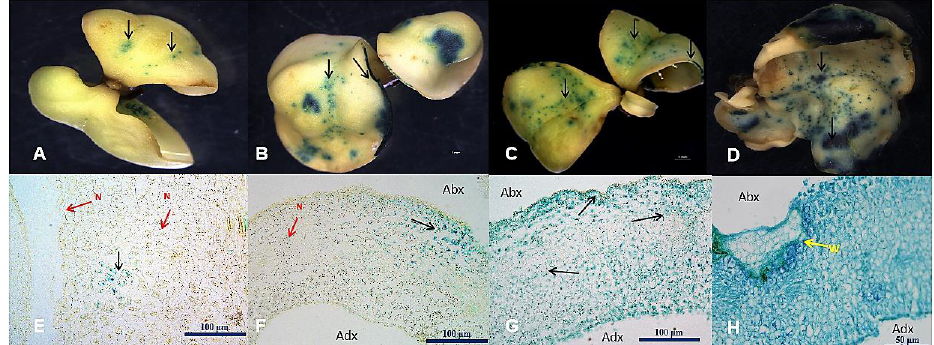
Figure 3. Various levels of GUS expression in Hevea brasiliensis after sonication frequency analysis. ( A , E ) 8 min of agrobacterial inoculation with 10 s sonication, black arrows indicate GUS expression in the vascular bundles and red arrows (N) indicate no transformed areas; ( B , F ) 8 min of infection with 30 s sonication, black arrows indicate GUS signals in the epidermis and vascular bundles in the explant; ( C , G ) show strong GUS signaling after 50 s sonication and 18 min of infection; the histogram in ( G ) clearly indicates the GUS signals in the epidermis and all the deeper cells inside the tissues, GUS signals were present in the abaxial (Abx) and adaxial (Adx) regions; ( D , H ) show 70 s sonication with 18 min of inoculation and lethal micro wounds (yellow arrow marked W) for the survival of tissues for secondary embryogenesis; GUS stain is spread all over the tissues in histogram ( H ). Bars are 50 μm and 100 μm.